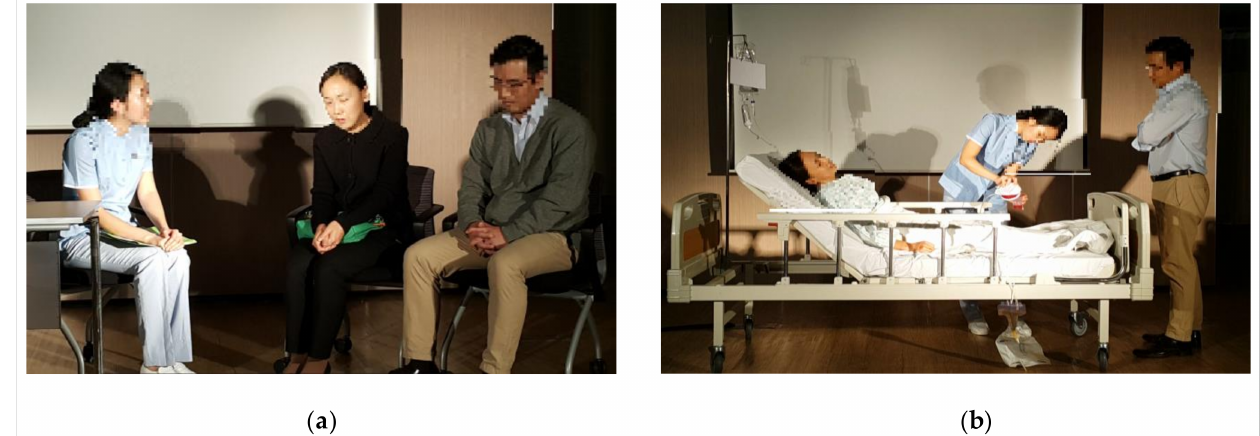
Figure 1. Dramatic scenes from this study: ( a ) Patient and caregiver counseling scene and ( b ) scene of performing nursing intervention after surgery. Reproduced with permission from authors E.E.S. and